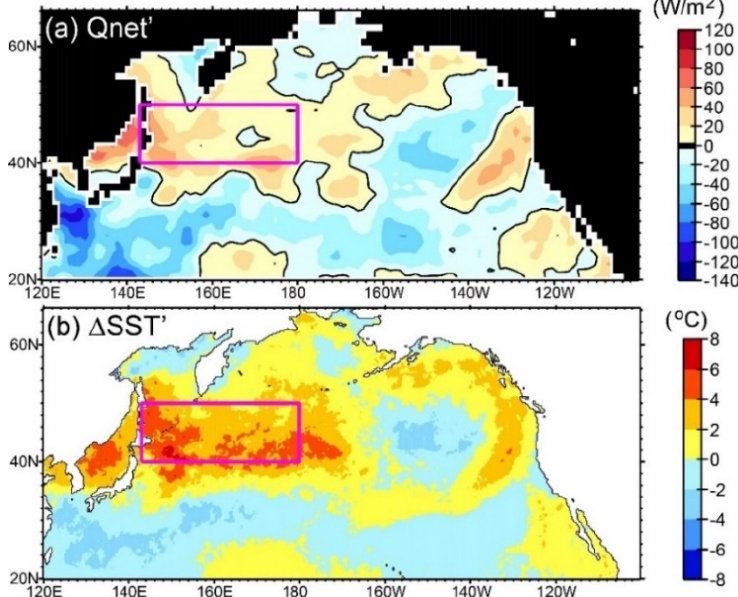
Figure 3. ( a ) Net heat flux anomalies (Qnet ′ ) at the sea surface during 10–30 July 2021. ( b ) SST anomaly differences between 10 and 30 July 2021 ( Δ SST ′ ). The pink rectangle indicates the focal area (143°E–180°, 40°–50°N).